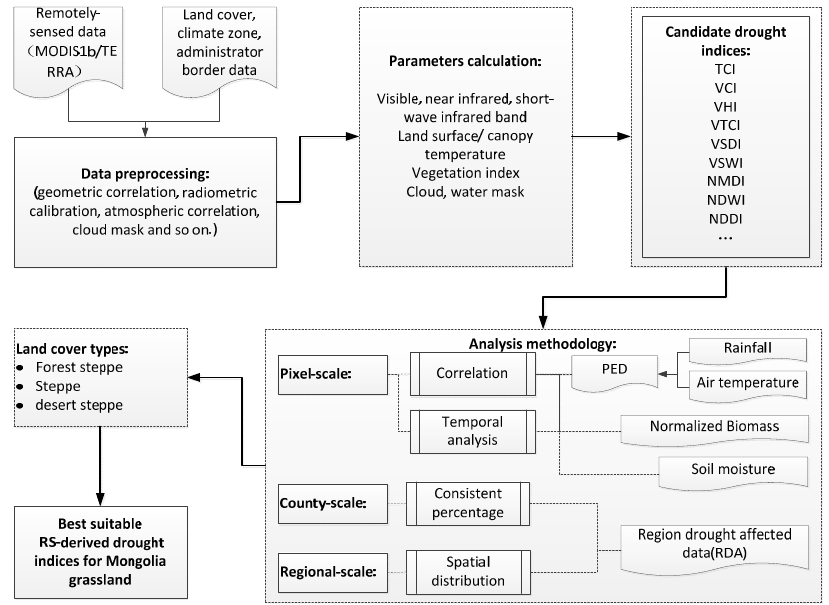
Figure 2. Adaptability analysis framework of the RS-derived drought indices in this paper.